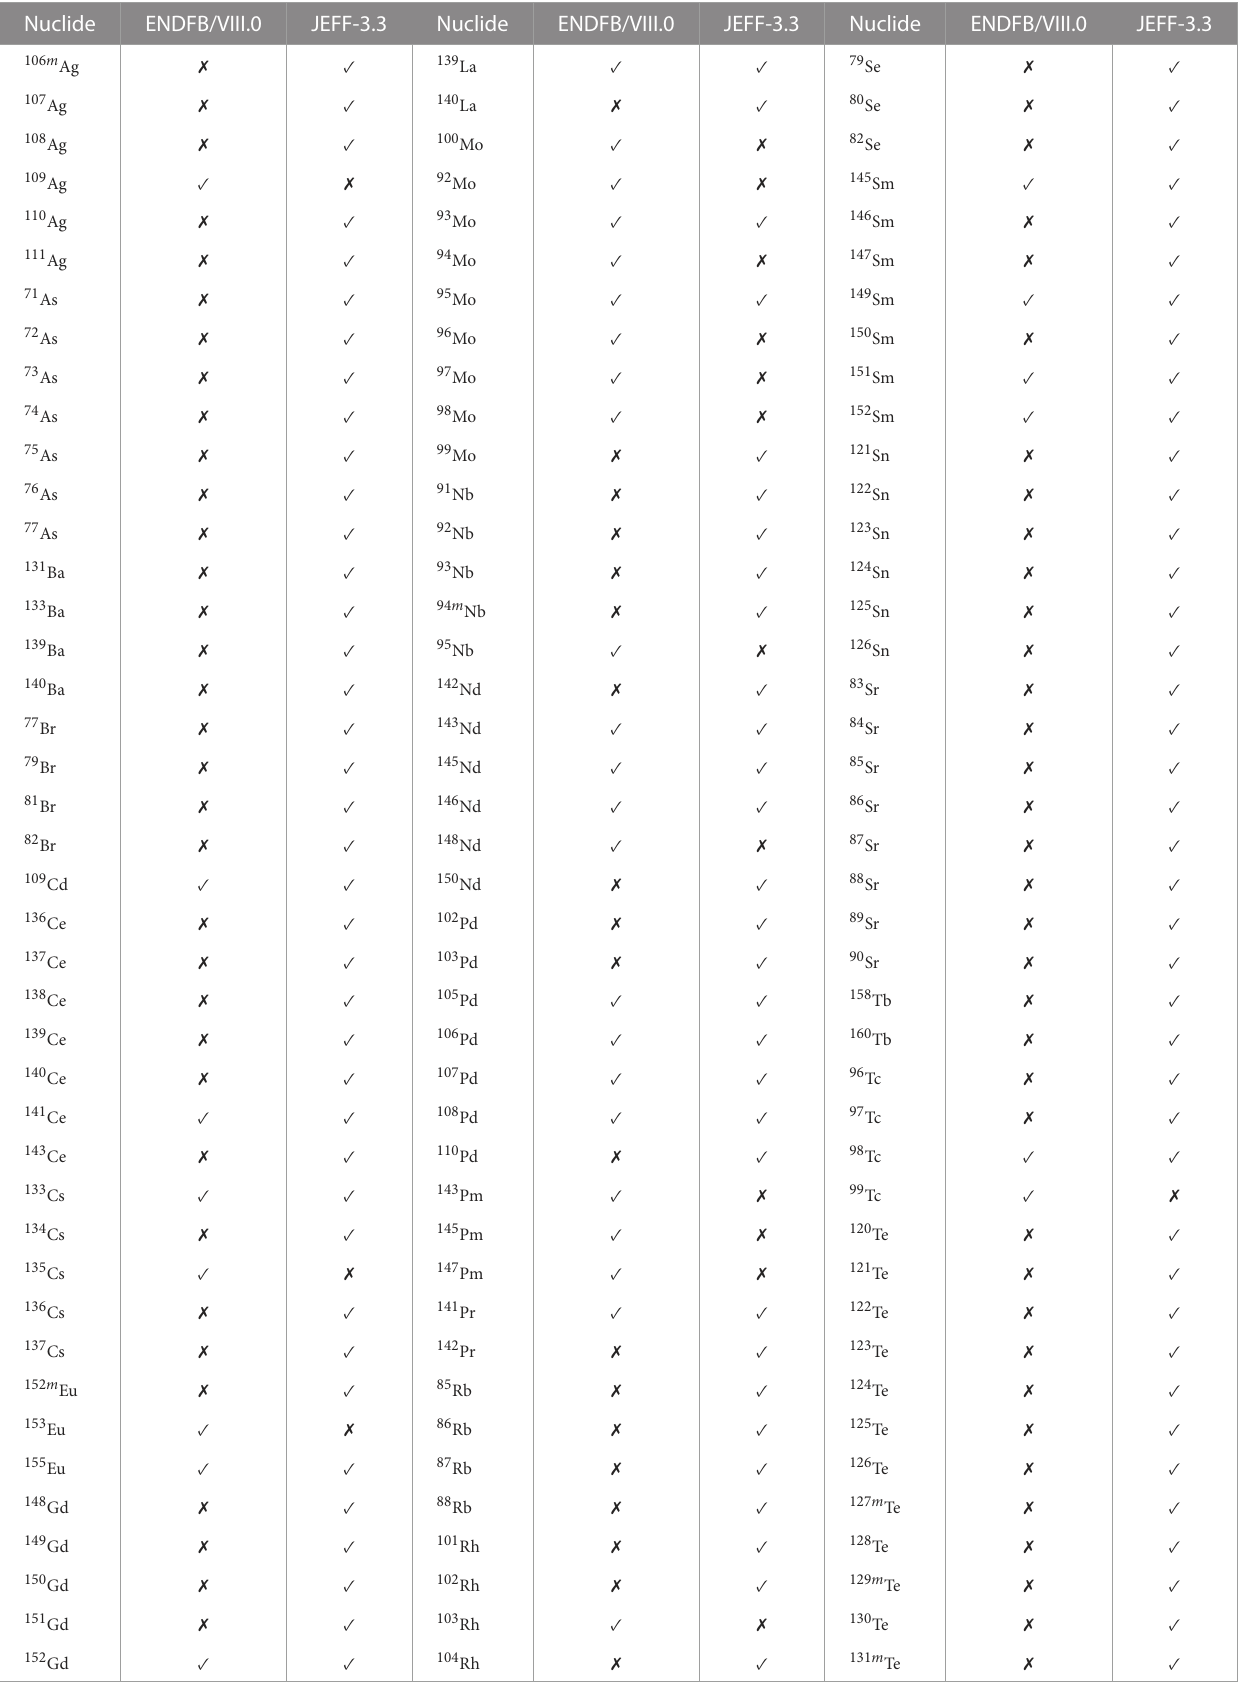
TABLE3 Fissionproductswhosecross-sectioncovariancematriceswereconsideredintheuncertaintypropagationstudy.